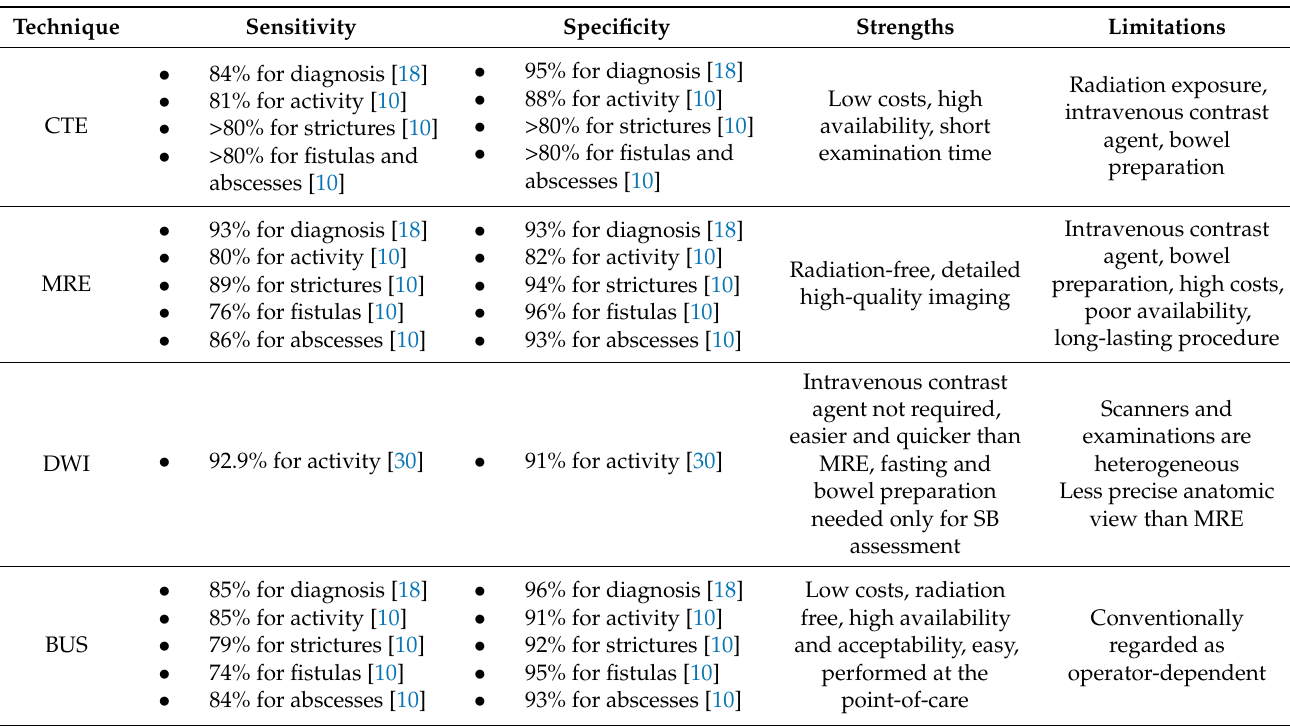
Table 1. Accuracy, advantages and disadvantages of the different imaging techniques for